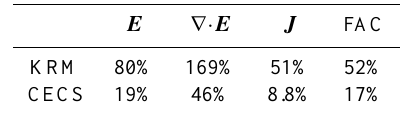
et al. (1981). The new method introduced here differs from